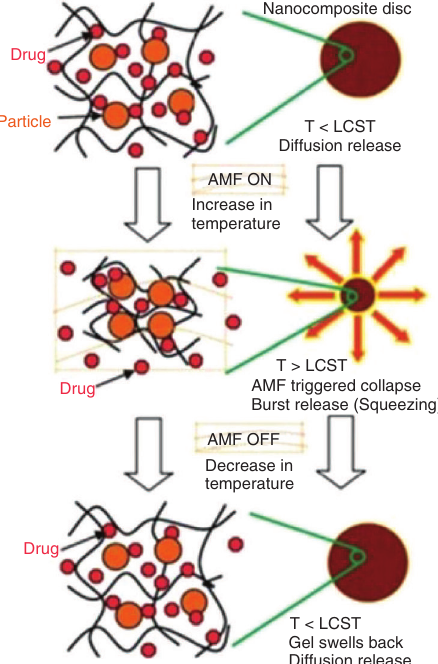
Figure 22: The remote controlled pulsatile drug release from a magnetic hydrogel nanocomposite. A schematic of AMF-induced heating, collapse and squeezing effects. Reproduced from Ref. [25] with the permission of The Royal Society of